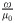
(a) Linear scaling factor of κ with respect to ωμ0 as a function of the relative non-compliant death rate μNμ0. Weakly efficacious non-compliant control (e.g. weakly efficacious aerial spray) is represented in the regime μNμ0≈1, and strongly efficacious non-compliant control is represented by large values of μNμ0. (b) Values of ξ as a function of the relative efficacy of compliant control to non-compliant control ΛC/μCΛN/μN and non-compliant control efficacy μN/pv. Relative compliant efficacy decreases along the vertical axis, and non-compliant efficacy increases along the horizontal axis. The limit of negligible extrinsic incubation period pv → ∞ is represented by the vertical axis μN/pv = 0. For the model parameters considered in Table 1, we have μ0 = pv, so the smallest possible value of μN/pv is 1 (which represents no control in non-compliant sites, e.g. no aerial spray), and all possible values of ξ will fall to the right of the solid black μN/pv = 1 line. Along this line, ξ decreases from 5/3 to 1 as ΛC/μCΛN/μN increases. In the limit of infinitely strong non-compliant control μN/pv → ∞, the dotted black line representing ξ = 1.5 asymptotes to the μN/pv axis.